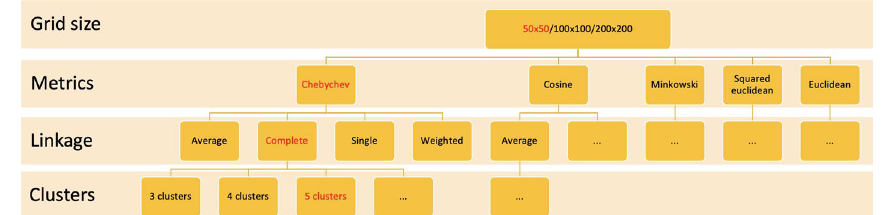
Fig. 3 The flow chart of the pipeline for determining the best combination of parameters for the hierarchical clustering. Parameters marked in red indicate one of the possible combinations